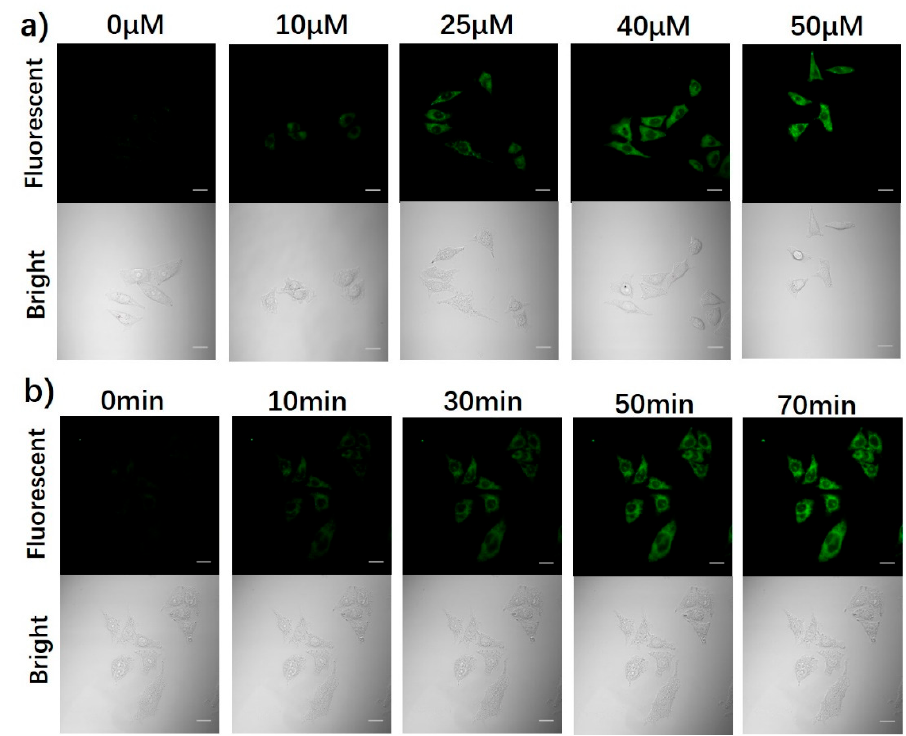
Figure 5. Confocal images after the addition of exogenous H 2 O 2 in MCF-7 cells. ( a ) Cells were stained with different concentrations of H 2 O 2 and then incubated with CMB (2 μ M). ( b ) Cells were pretreated with H 2 O 2 (50 μ M), and then incubated with CMB (2 μ M) at different time points (0 to 70 min). The excitation wavelength was 405 nm and the emission was collected at 420 to 520 nm. Scale bar = 20 μ m.